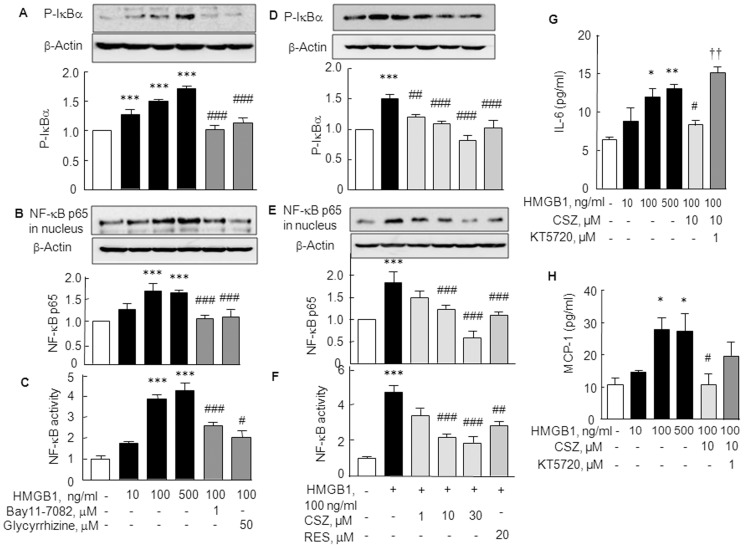
Inhibition of NF-κB p65 expression and activity by cilostazol.(A, B and C) HMGB1-induced increase in phosphorylated IκBα (A) and increase in the nuclear translocation of NF-κB (B) and DNA binding activity of NF-κB in synovial fibroblasts (C). These effects were inhibited by glycyrrhizin (50 µM, an inhibitor of HMGB1 binding to DNA) and by Bay11–7082 (1 µM). (D, E and F) Cilostazol (CSZ; 1, 10 and 30 µM) and resveratrol (RES; 20 µM) decreased phosphorylated IκBα (D), nuclear NF-κB (E) levels and DNA binding activity of NF-κB (F). (G, H) Suppression of HMGB1-stimulated production of proinflammatory cytokines, IL-6 and MCP-1, by cilostazol (10 µM) and the reversal of this suppression by KT5720 (1 µM) in cultured medium. Results are the means ±SEM of 3–4 experiments. *P<0.05, **P<0.01, ***P<0.001 vs. no treatment; #
P<0.05, ##
P<0.01, ###
P<0.001 vs. HMGB1 alone; ††
P<0.01 vs. 10 µM cilostazol.